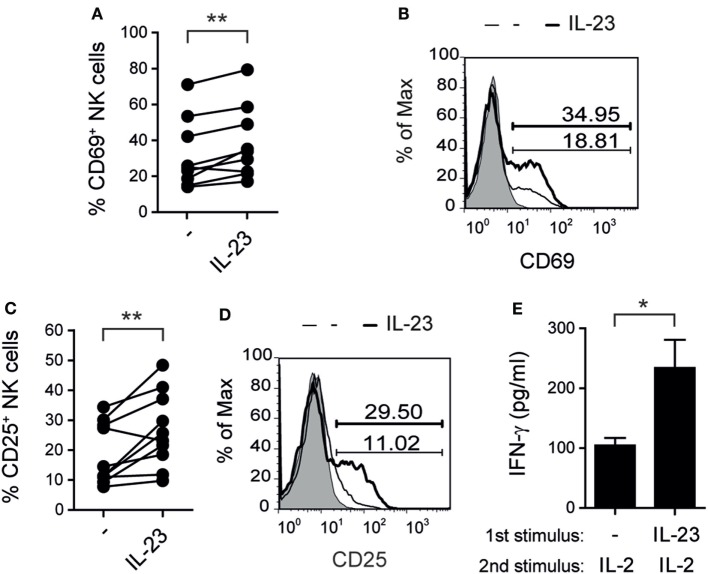
Interleukin (IL)-23 activates natural killer (NK) cells. (A–D) Percentage of NK cells expressing CD69 (A,B) or CD25 (C,D) after 5 days of culture in the absence (−) or in the presence of 10 ng/ml of IL-23; n = 9 (A) and n = 10 (C). Representative histograms are shown in (B,D). Gray: IC. Thin line: unstimulated NK cells. Thick line: NK cells stimulated with IL-23. Numbers within histograms: percentage of positive cells for each marker in each condition. (E) IFN-γ secretion by NK cells cultured for 5 days in the absence (−) or in the presence of 10 ng/ml of IL-23 and thereafter re-stimulated 24 h with 8 ng/ml of IL-2; n = 7. Mean ± SEM are shown in (E). ns, not significant; *p < 0.05; **p < 0.01; paired t-test (A,C,E).